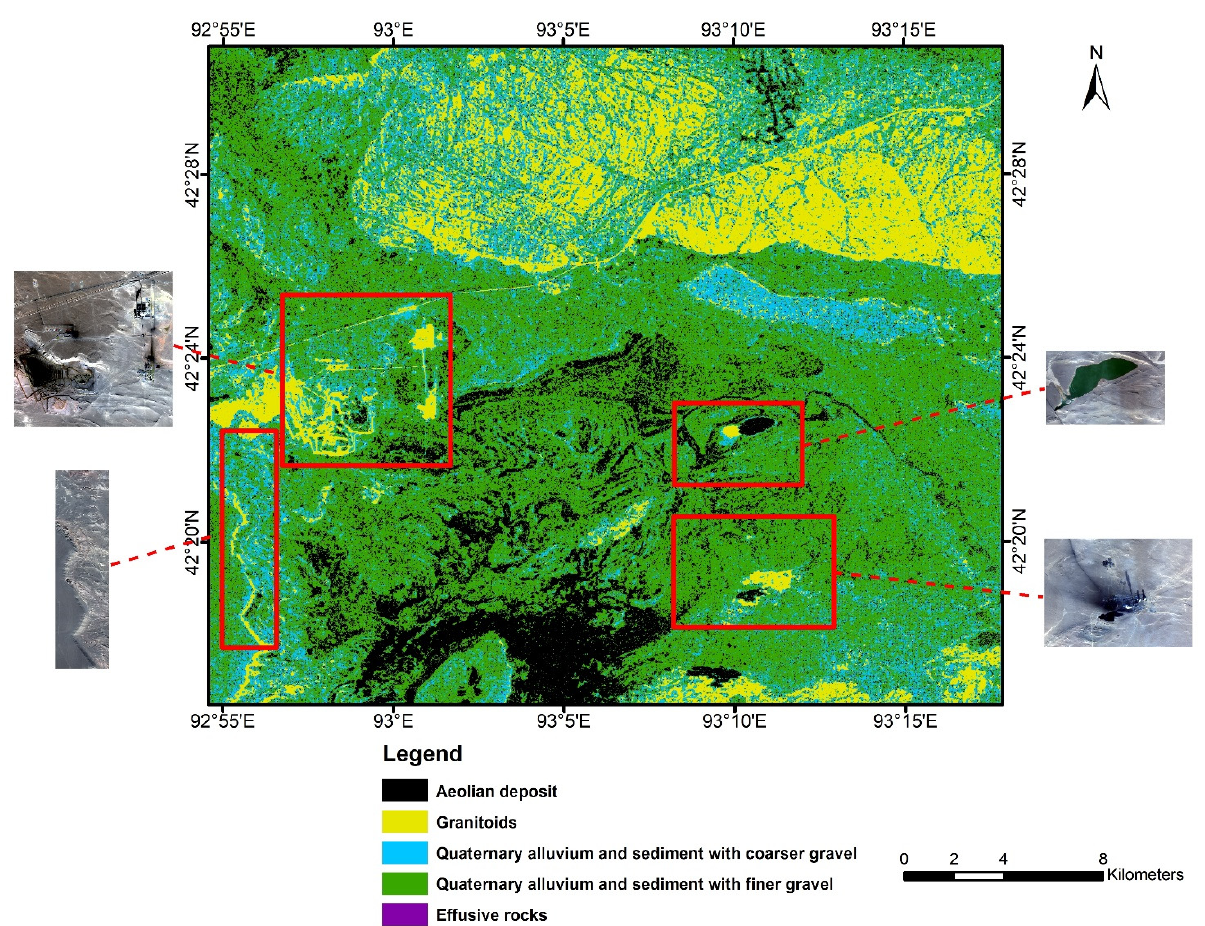
Figure 8. Results of lithological mapping using parameters after DWT (MF: db13). The water body and landmark buildings in the figure are marked with WorldView-2 data© DigitalGlobe, Inc. (Westminster, CO, USA) (2020), provided by European Space Imaging.